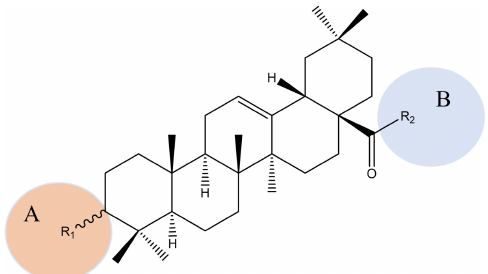
Figure 7. Structure–activity relationships of OA derivatives against HCV. A: 1. 3-R1 in the β configuration is better than α configuration. 2. A free carboxyl group at the end of R1 is better than a free amino group. B: The R2 hydroxyl group is better than a methoxy group, and has the potential to inhibit HCV